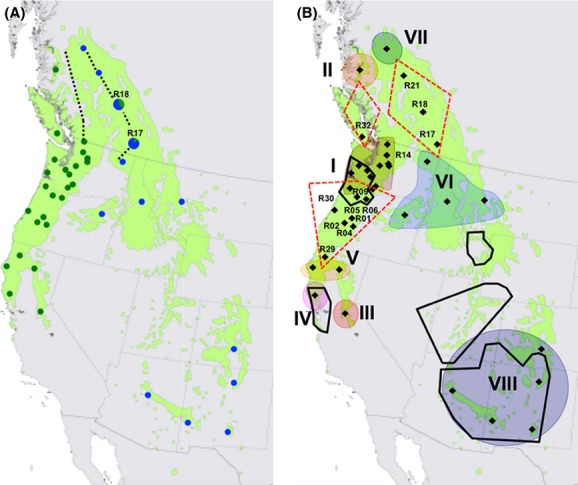
Distribution maps of Douglas-fir populations with their assignment to a variety (A), or to an intravarietal genetic cluster (B) as estimated by STRUCTURE. Populations R17, and R18 (map A) represent populations where individuals of both varieties, coastal (green color) and Rocky Mountain variety (blue color), were present. Dotted lines indicate the borders of the assumed intervarietal hybrid zone (von Rudloff 1973; Li and Adams 1989; Gugger et al. 2010; Wei et al. 2011). Map (B) displays eight intravarietal genetic clusters (I–VIII). Cluster-admixed populations (0.2 < Qvar < 0.8) are situated in overlapping (red dashed line) between two clusters I-II, I-(III+IV+V), and VI-VII. Black solid lines indicate glacial refugia based on fossil data detected by Gugger et al. (2010).